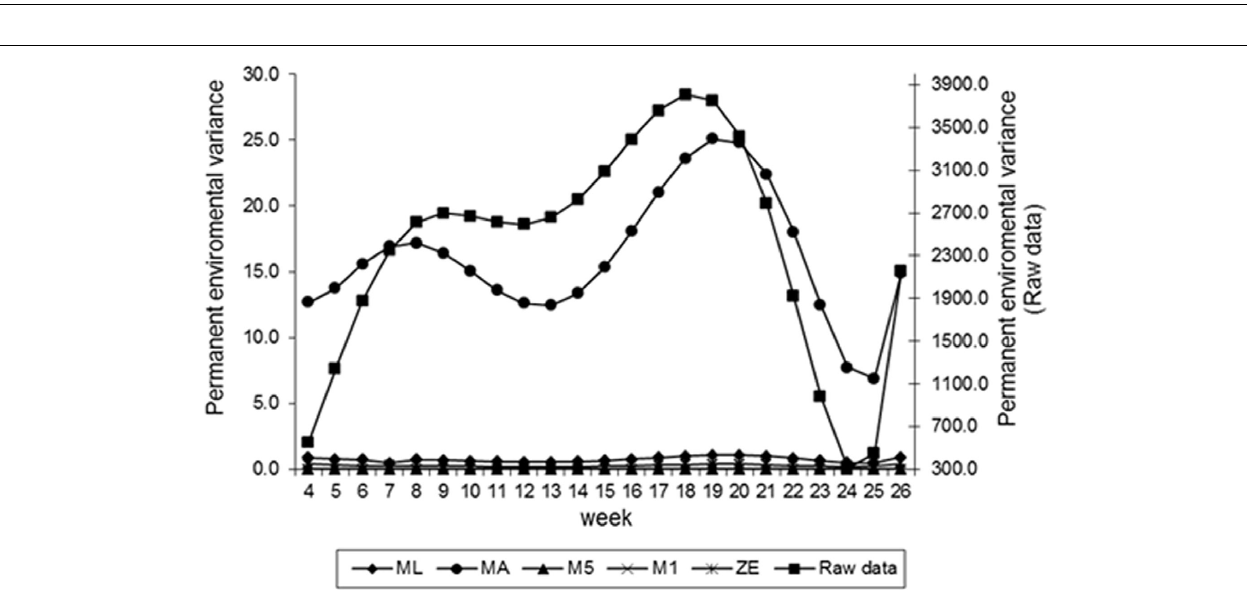
FIGURE 3 | Estimates of permanent environment variance of fecal egg count (FEC) over time for different values of λ .